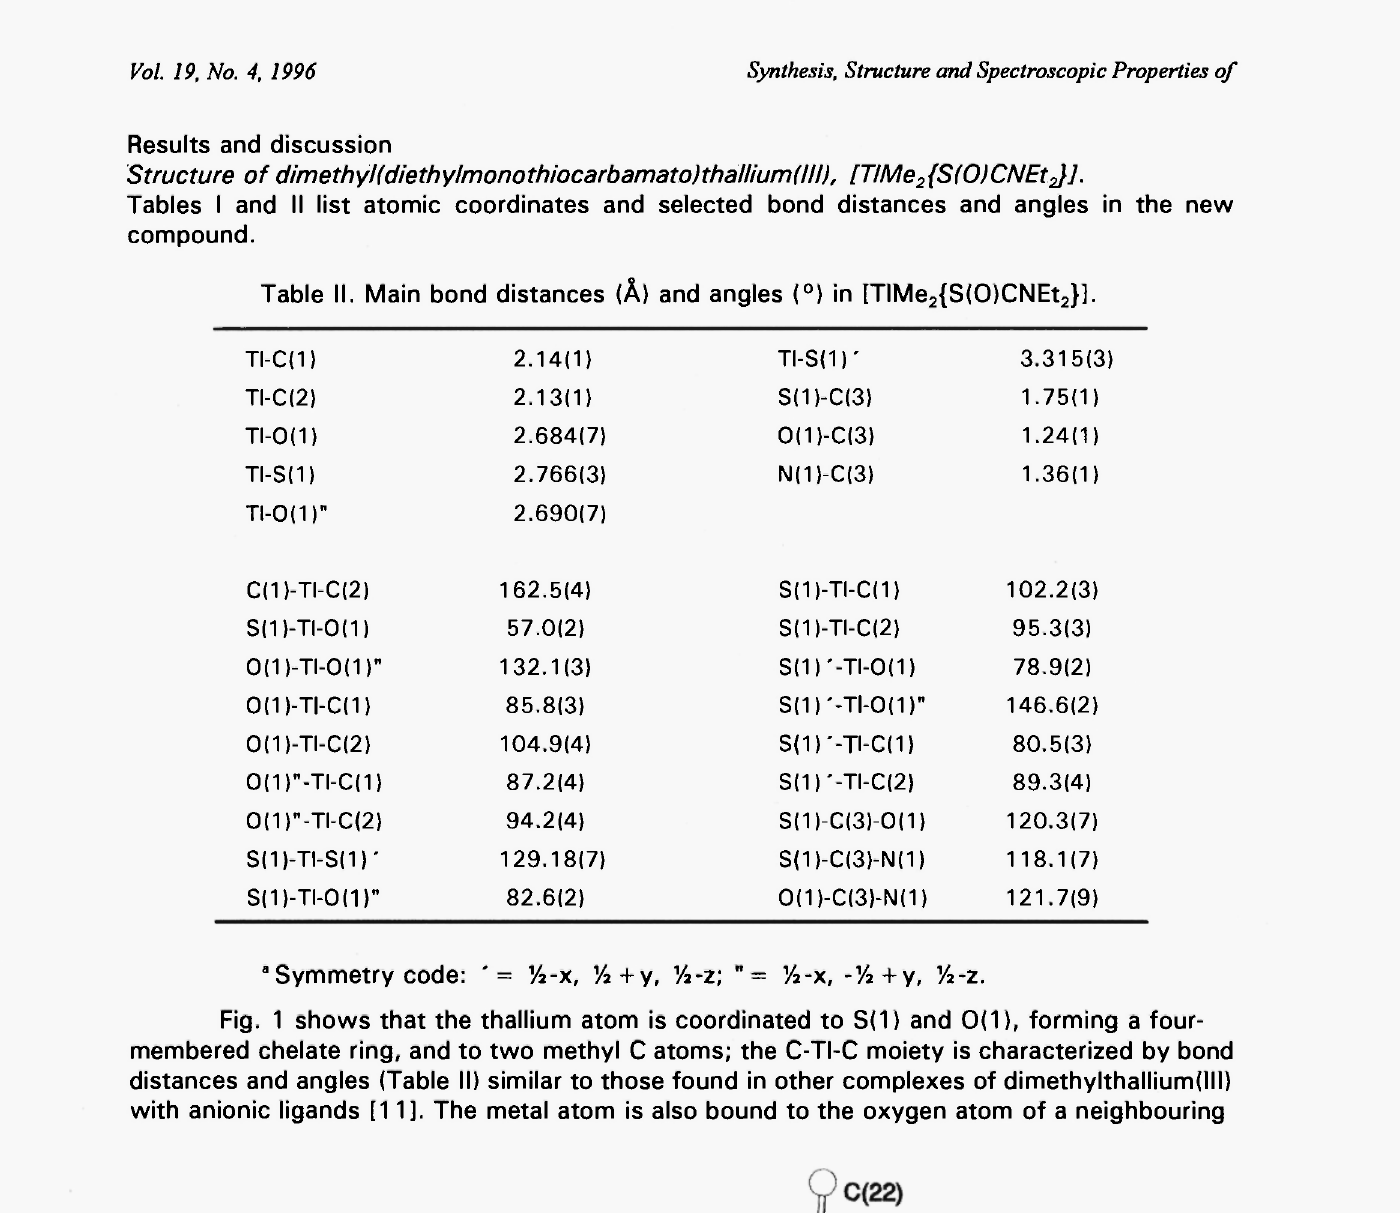
Table II. Main bond distances (Ä) and angles (°) in [TIMe 2 {S(0)CNEt 2 }].